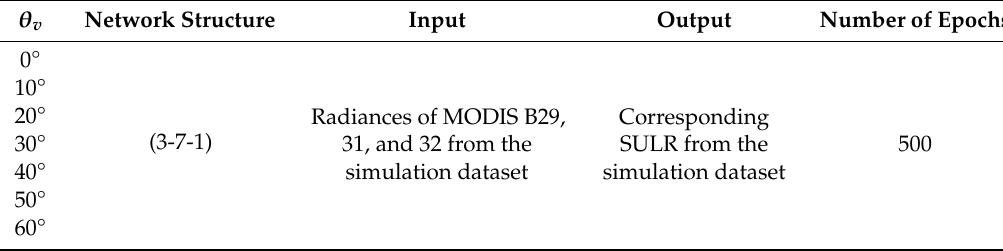
Table 5. The structure and training parameters of the BPNN model used for each VZA. θ v